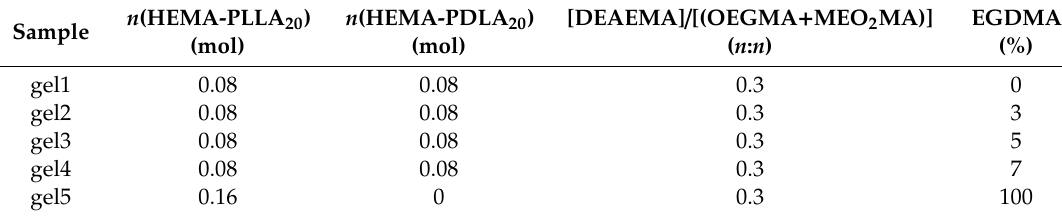
Table 1. Synthesis data of hydrogels.